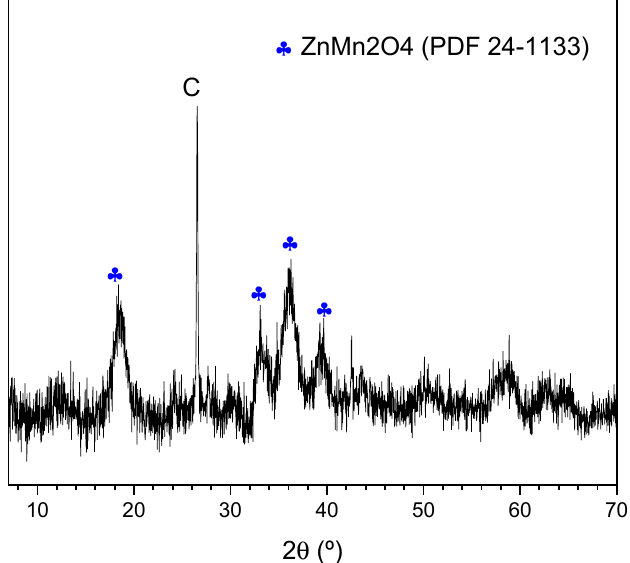
Figure 9. X-ray diffraction pattern “ex situ” of HKMn post-mortem.